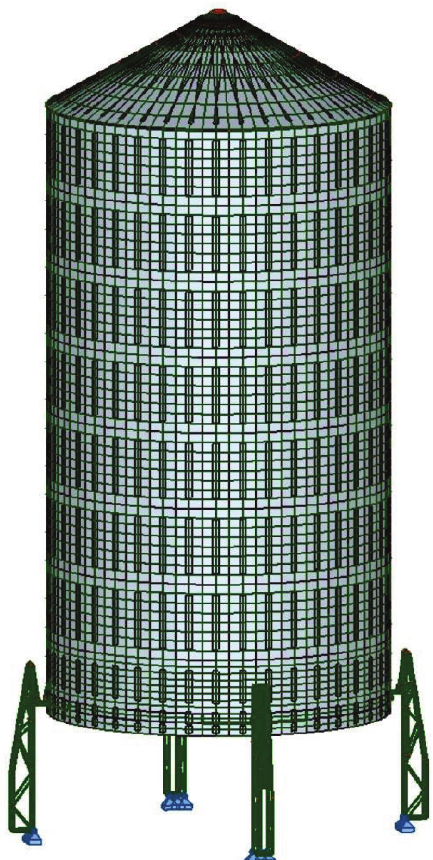
Fig. 4. Model of a system tank – four towers Figure 4: Model of a system tank-four